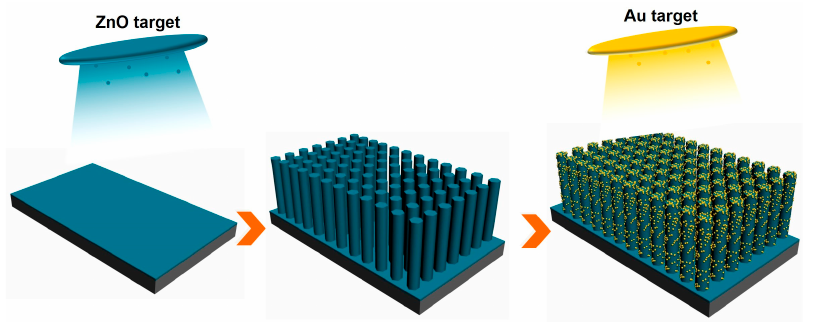
Figure 1. Preparation process of Au/ZnO NRs array